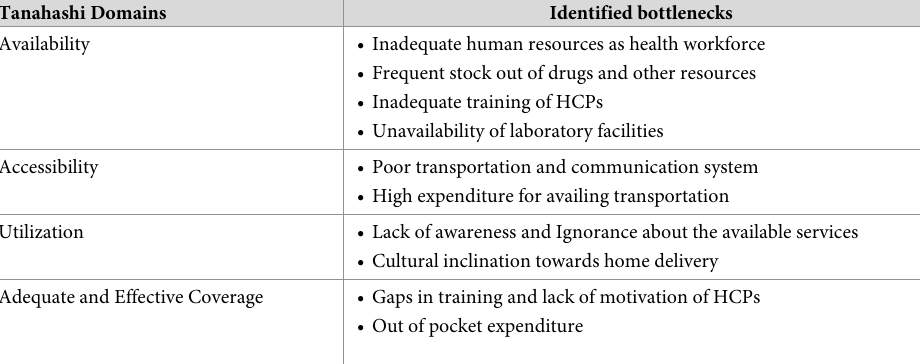
Table 6. Identified bottlenecks for different domains of Tanahashi